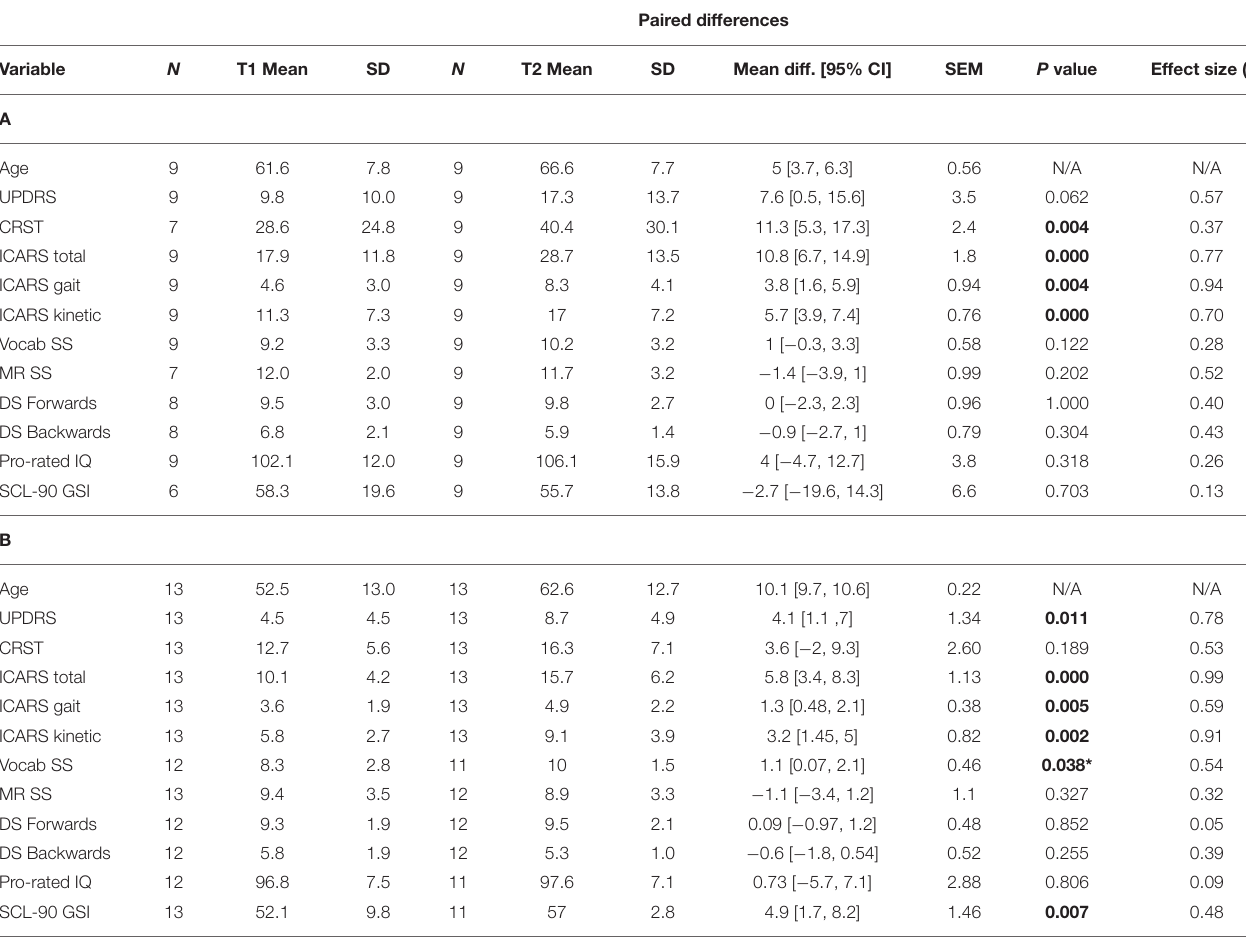
TABLE 1 | Summary statistics for all phenotypic scores at Time 1 and Time 2 in male (A) and female (B) samples included in the progression analysis, and the p values for significance of the T2-T1 differences for each sex separately.